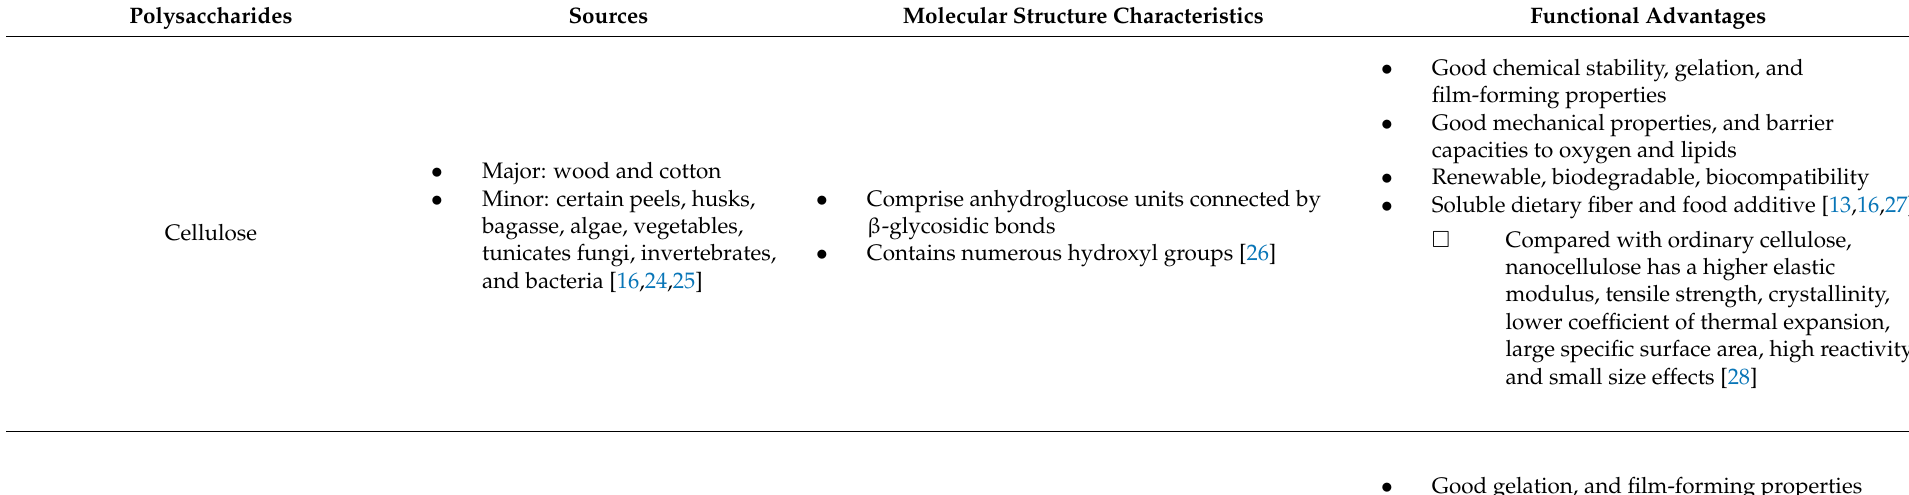
Table 1. Sources, compositions, structures, and outstanding characteristics of five polysaccharides for edible packaging application.